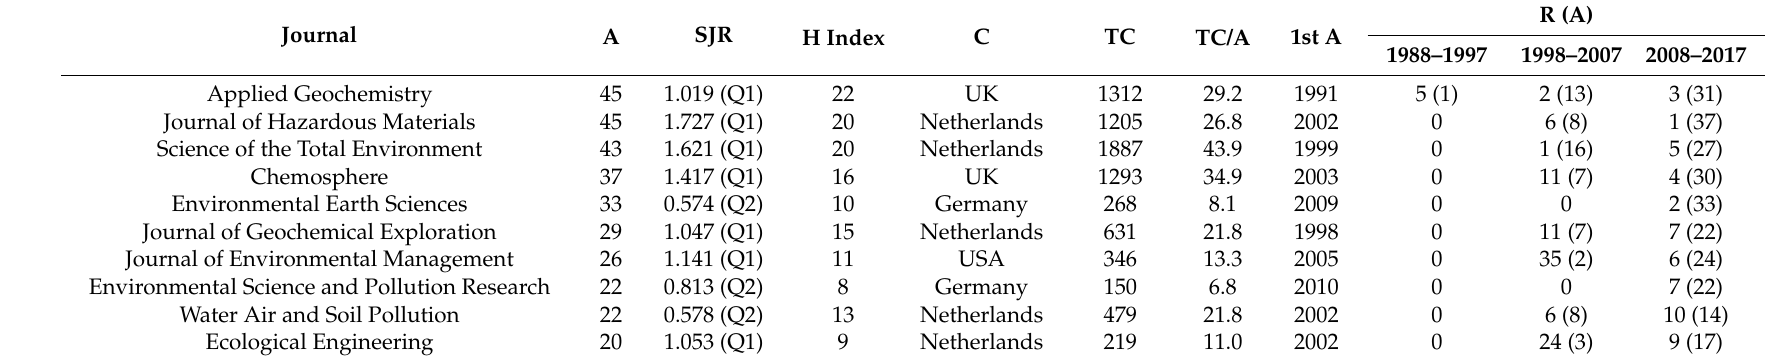
Table 9. Top 10 most productive journals for MMW